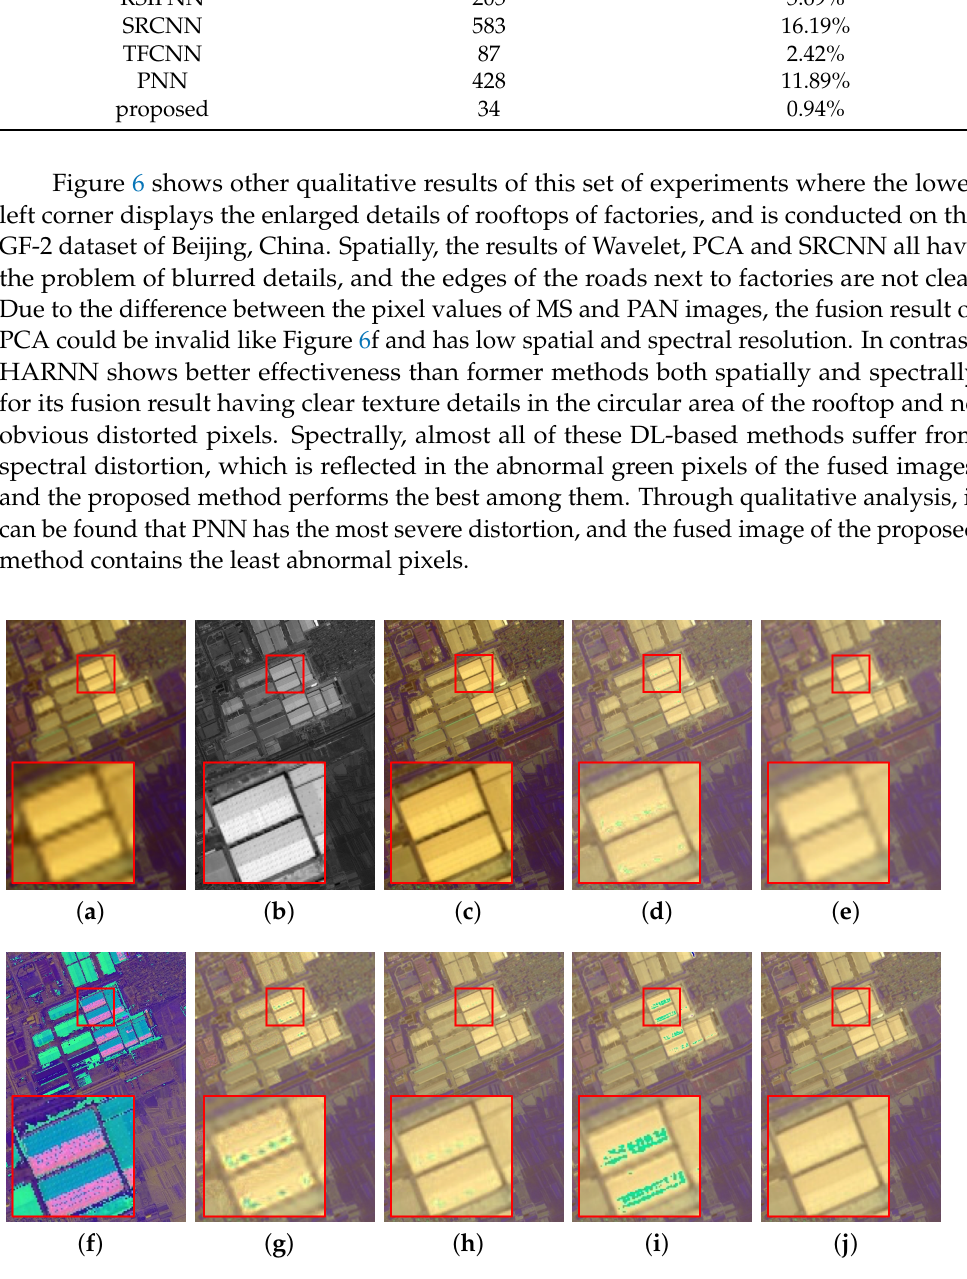
Figure 6. Comparison results obtained by different methods (downsampled GF-1 image). ( a ) LRMS image. ( b ) HRPAN image. ( c ) Reference MS image. ( d – j ) Pansharpening result of RSIFNN, Wavelet, PCA, SRCNN, TFCNN, PNN and the proposed